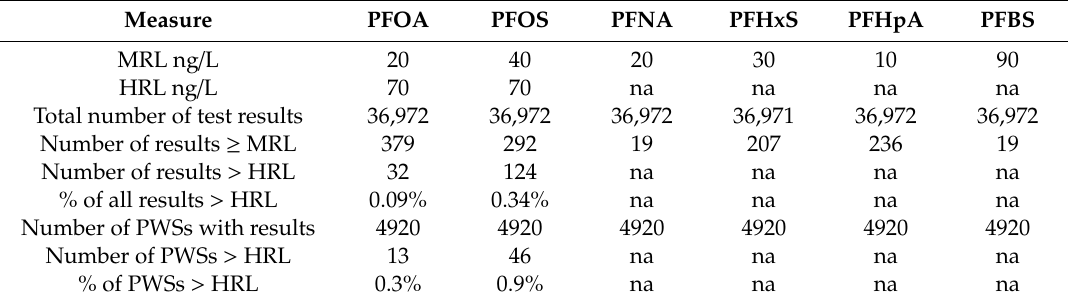
Table 3. PFAS monitoring results under the unregulated contaminant monitoring rule (UCMR) 3 [34]. 1.